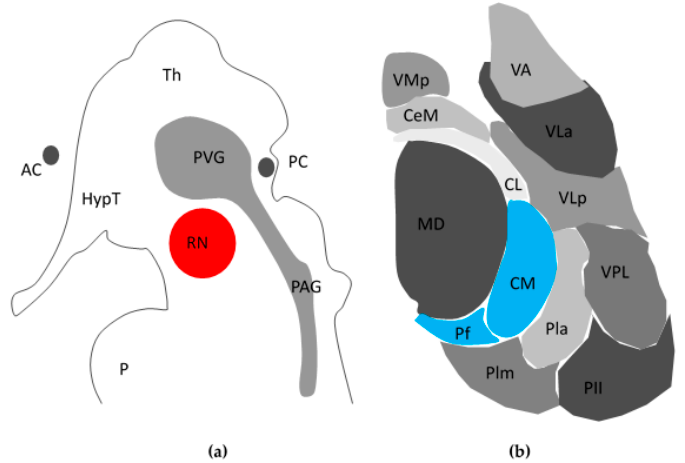
Figure 1. Schematic view of peri-aqueductal grey/Periventricular grey (PAG/PVG) and centromedian intralaminar parafasciular complex (CMPf). ( a ) Sagittal cross-sectional schema of PVG/PAG within midbrain/diencephalon; ( b ) Axial cross section of left thalamus demonstrating CMPf ( blue ) adapted from Weigel and Kraus, 2004 [30]. AC: Anterior Commissure; HypT: Hypothalamus; RN: Red Nucleus; PC: Posterior Commissure; Th: Thalamus; P: Pons; MD: Mediodorsal nucleus; VMp: Ventral Posteromedial nucleus; CeM: Central Medial nucleus; CL: Centrolateral; Plm: Medial nucleus of Pulvinar; Pll: Lateral nucleus of Pulvinar; Pla: Anterior nucleus of Pulvinar; VPL: Ventral Posterior Lateral nucleus; VLp: Ventrolateral Posterior nucleus; VLa: Ventrolateral Anterior nucleus; VA: Ventral Anterior nucleus.